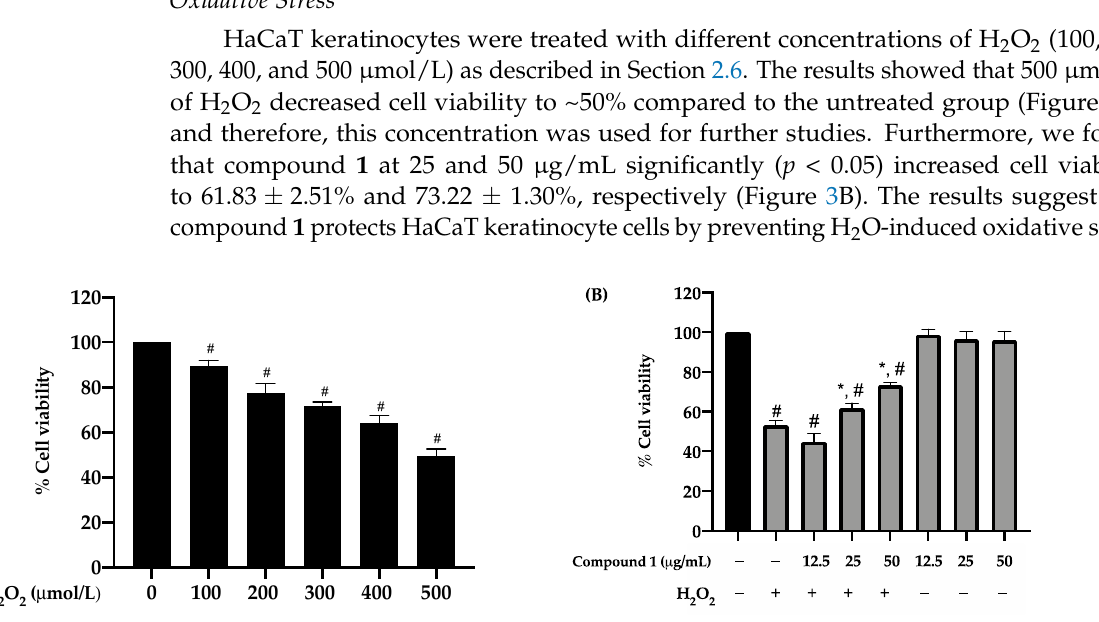
Figure 2. Effect of compounds 1–5 on cell viability of HaCaT keratinocytes. Cells were treated with a concentration ( A ) 50 and ( B ) 100 µg/mL of the test sample for 24 h. After treatment, the percent cell viability was measured using the 3-(4,5-dimethlthiazol-2-yl)-2,5-diphenyl tetrazolium bromide tetrazolium (MTT) assay. Graphs showed mean ± SD values of four replication. # p < 0.05 indicates significant differences from the untreated group.